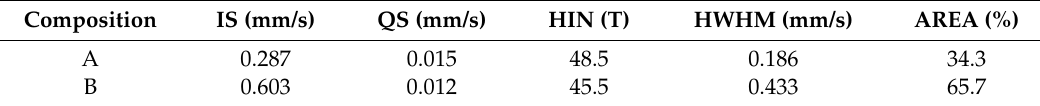
Table 1. Mössbauer spectrum parameters of pure Fe 3 O 4 hollow microspheres: IS is the isomer shift, QS the quadrupole splitting, HIN the hyperfine field, HWHM the half width at half maximum and AREA the relative absorption